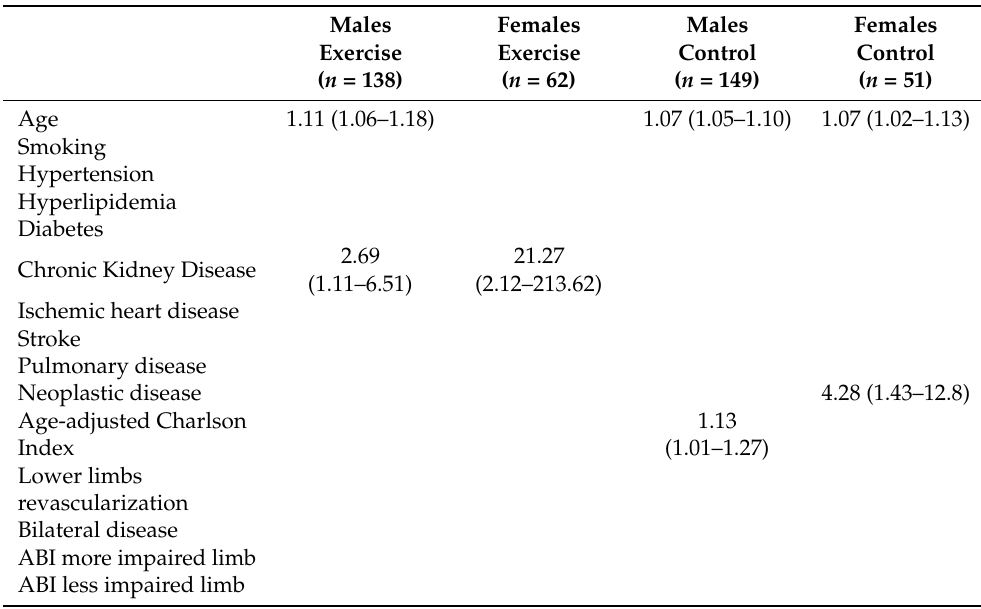
Table 4. Multivariate hazard ratios (95% confidence interval) of the study variables for the prediction of 7-year survival probability in the four patient